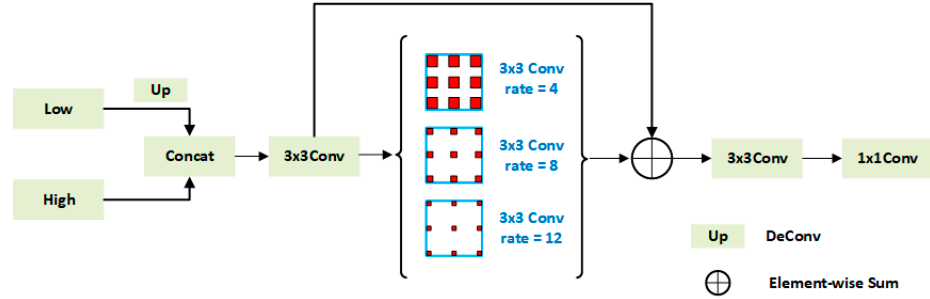
Figure 3. PCM architecture.